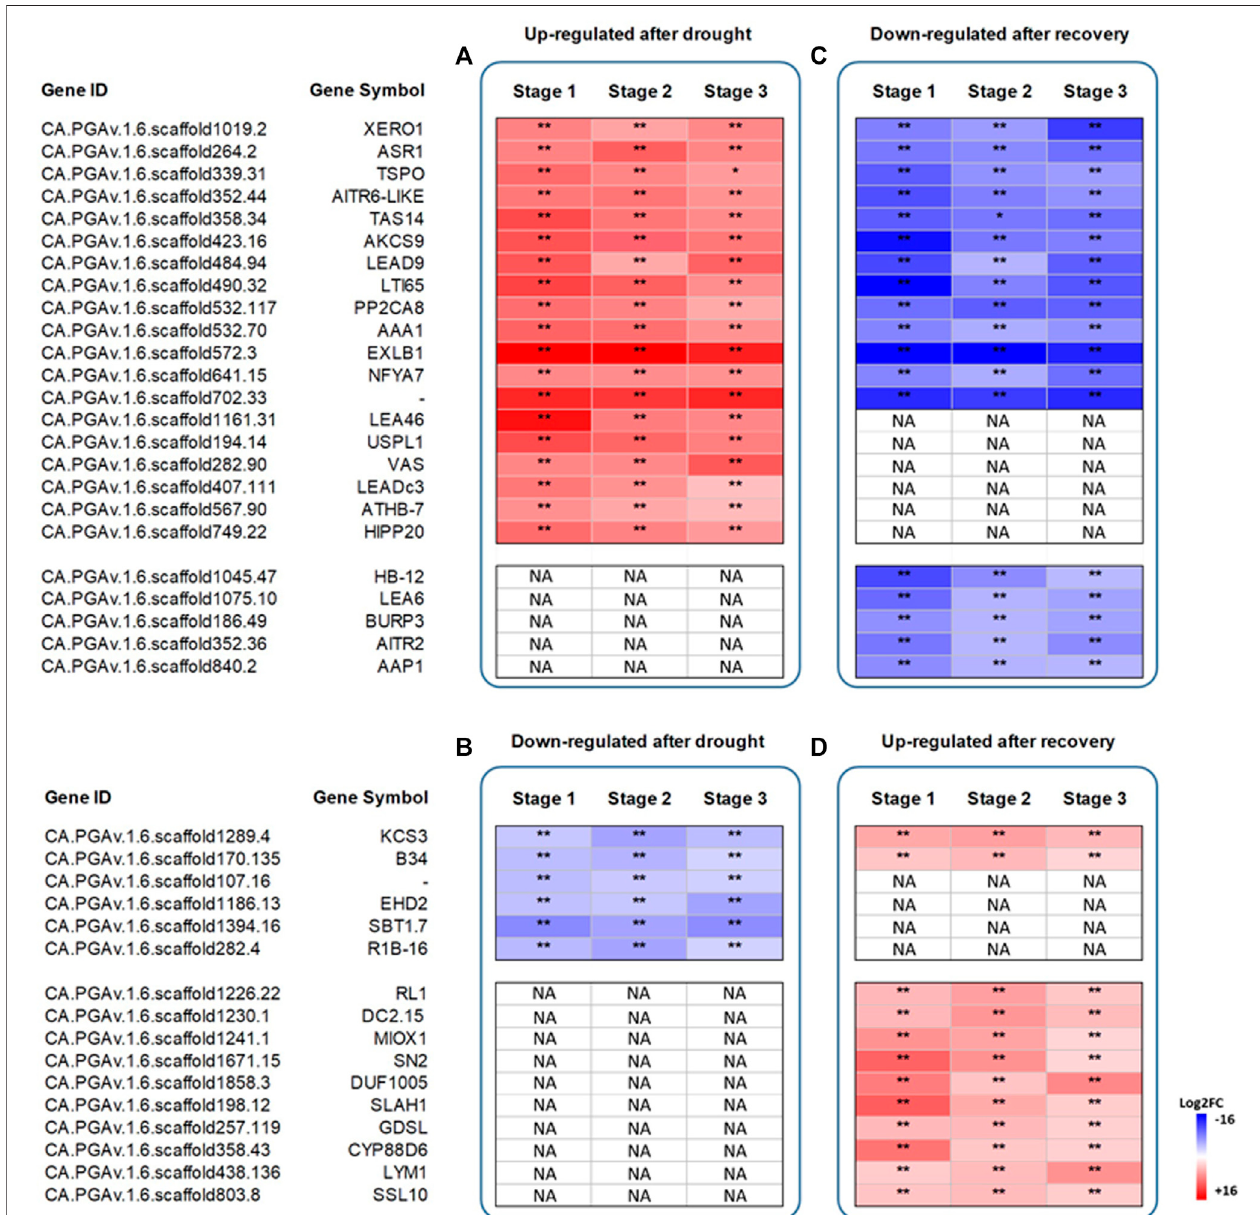
FIGURE 3 | Heatmap showing the log2 fold change differences in the expression pro fi les of the top 30 common DEGs at the three stages of plant development. Genes upregulated after drought stress or recovery (Panel A and D ) and genes downregulated after drought stress or recovery (Panel B and C ). Data represent the means of three biological replicates. Asterisks represent statistically signi fi cant differences ( p values) between control plants and stressed (droughted) plants,andbetweenstressed(droughted)plantsandrecoveryplants.The p valueswereadjustedusingtheBenjaminiandHochbergmethod.Corrected p valueof 0.005 and |log2 (Fold Change)| of 1 were set as the threshold for signi fi cantly different expression. White fi elds indicate the absence of signi fi cant differences between treatments. NA stands for “ Not applicable ”